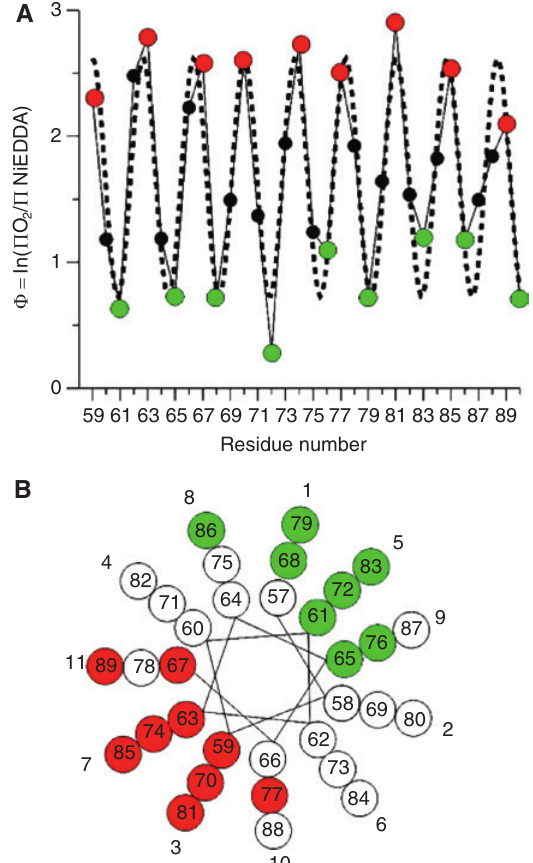
Figure 7: Secondary structure and topology of R1-labeled α -synuclein. (A) The ratios of the O and NiEDDA accessibilities are 2 summarized by the contrast parameter Φ . High Φ values indicate lipid-exposed sites (red) whereas low Φ values indicate solvent- exposed sites (green). The dashed line indicates the best fit to a cosine function resulting in a periodicity of 3.67 aa per turn. (B) When residues are plotted on a helical wheel with a periodicity of 3.67 aa per turn, lipid-exposed sites (red) are on one side whereas solvent-exposed sites (green) lie on the opposite side. White circles denote residues with Φ values that are neither maxima nor minima. The figure was reprinted from Jao CC, Der-Sarkissian A, Chen J, Langen R. Proc. Natl. Acad. Sci. USA. 2004, 101, 8331–8336. Copyright (2004) National Academy of Sciences, USA, and the kind agreement of Dr. Ralf